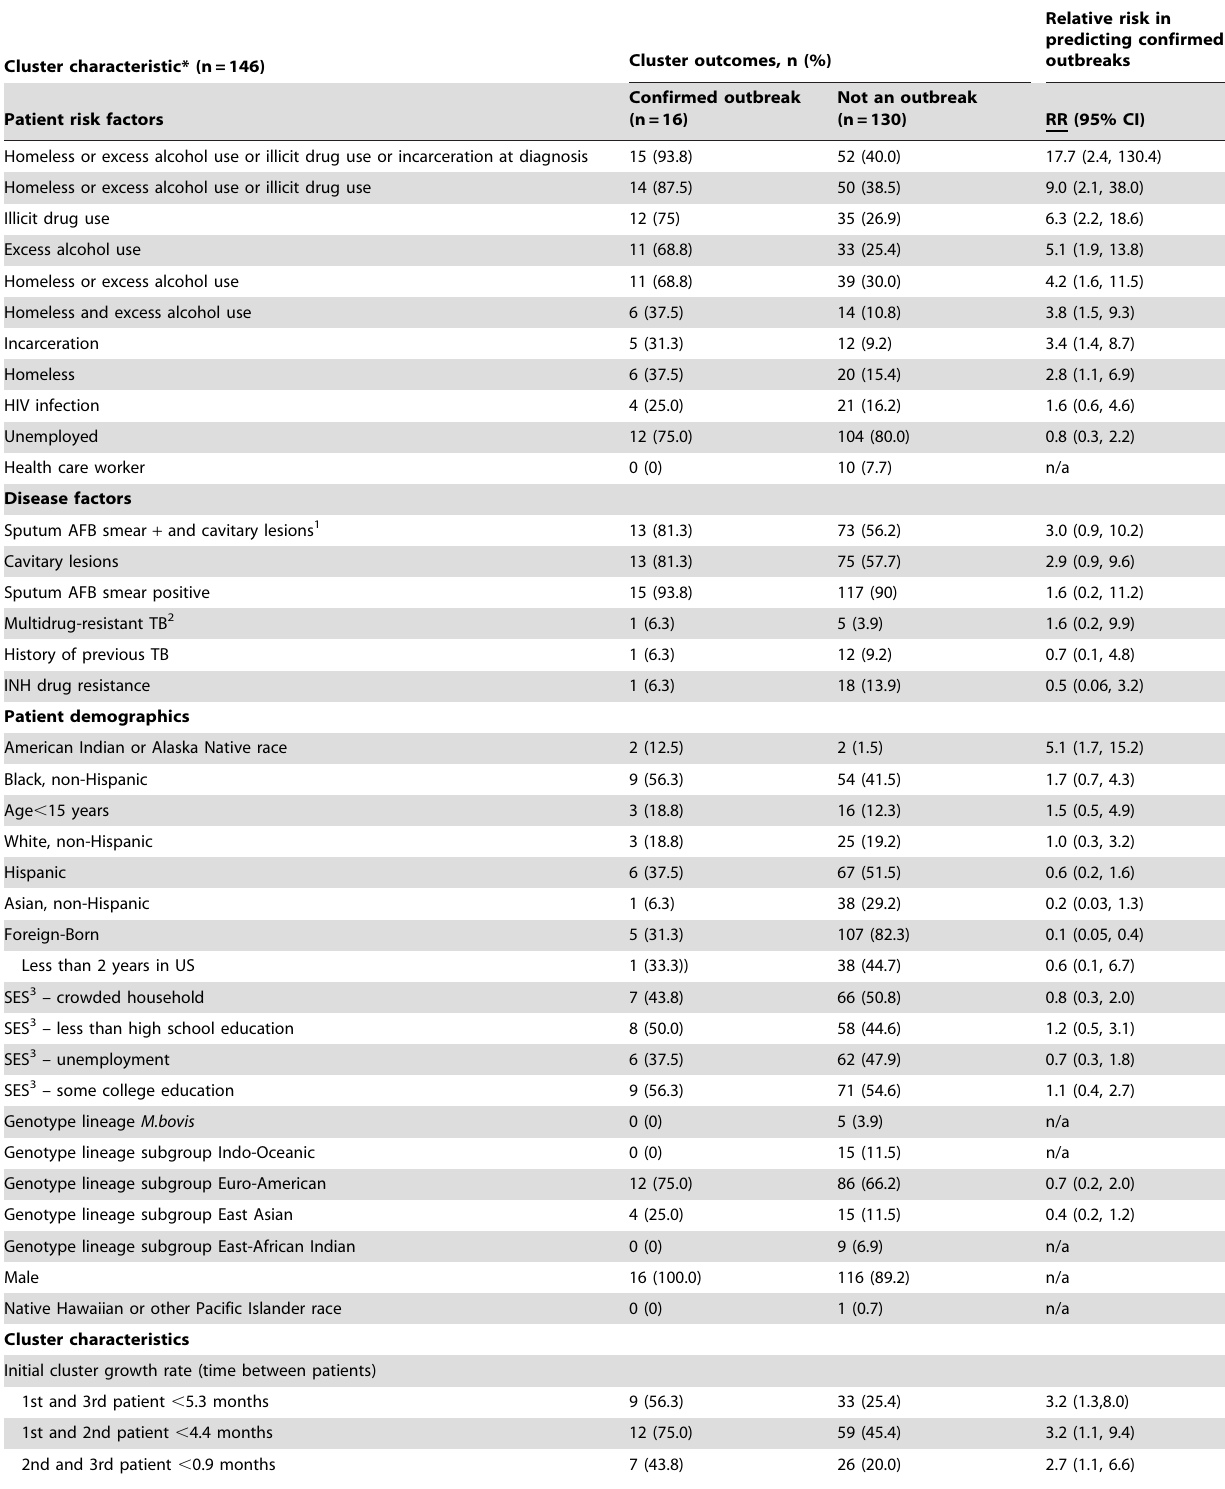
Table 1. Patient and cluster characteristics of tuberculosis (TB) genotype clusters and associated risk of the cluster becoming an outbreak within 24 months after diagnosis of the 3 rd